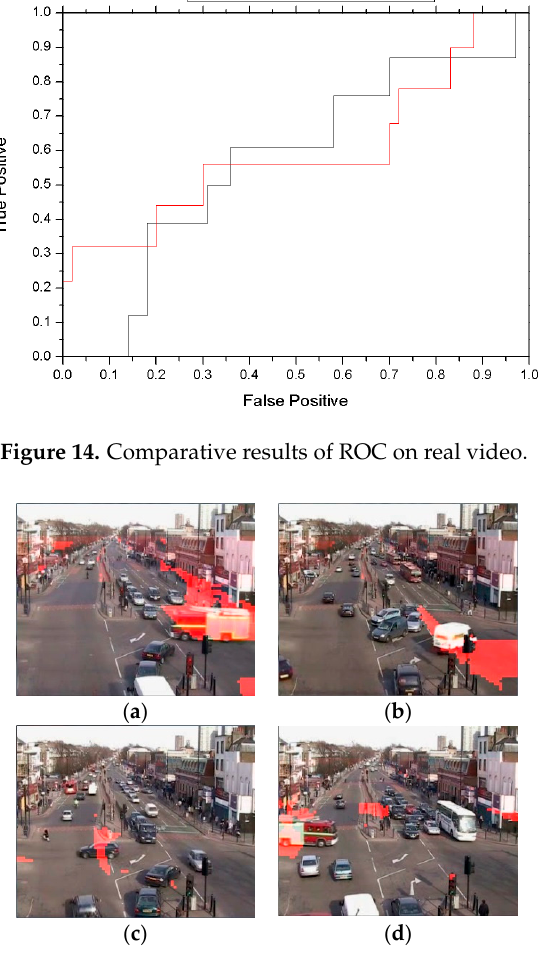
Figure 15. Locating abnormal events by RTM-HSVG.